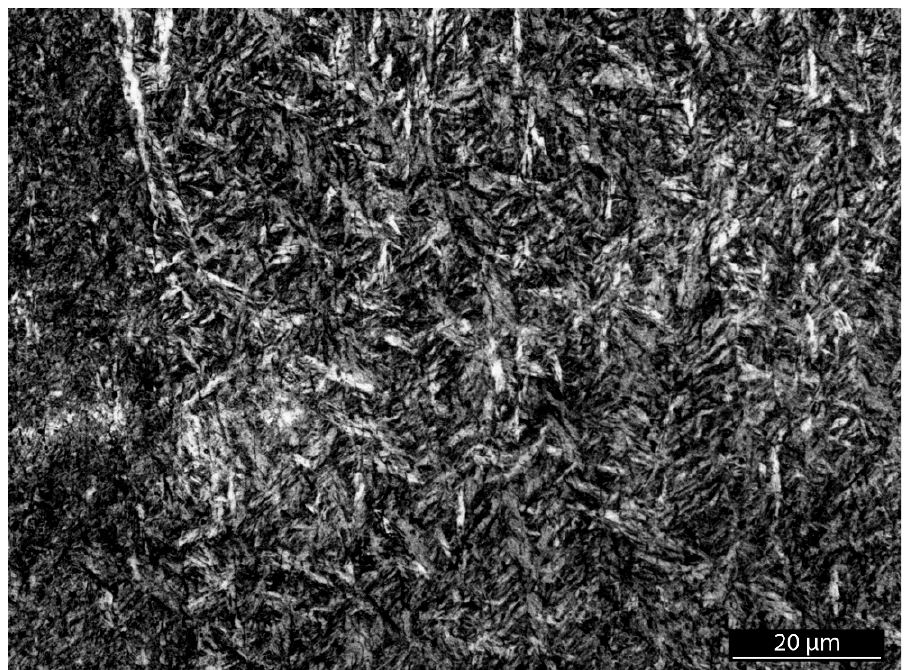
Figure 4. Microstructure of the heat-treated metal.